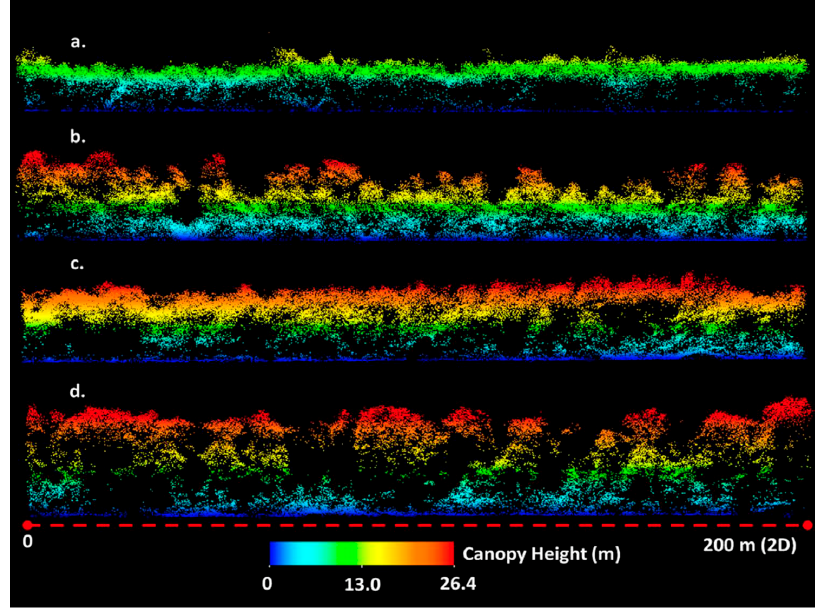
Figure 10. HRQLS-1 SPL point cloud profiles showing different growth patterns within a 1 square kilometer of forested area in Garrett County, MD. ( a ) Short even aged stand with little understory vegetation; ( b ) Uneven aged stand composed of tall trees and dense midstory vegetation; ( c ) Even aged stand with some mid and understory growth; ( d ) Tall open stand with distinct understory vegetation (Courtesy of the University of Maryland [11]).